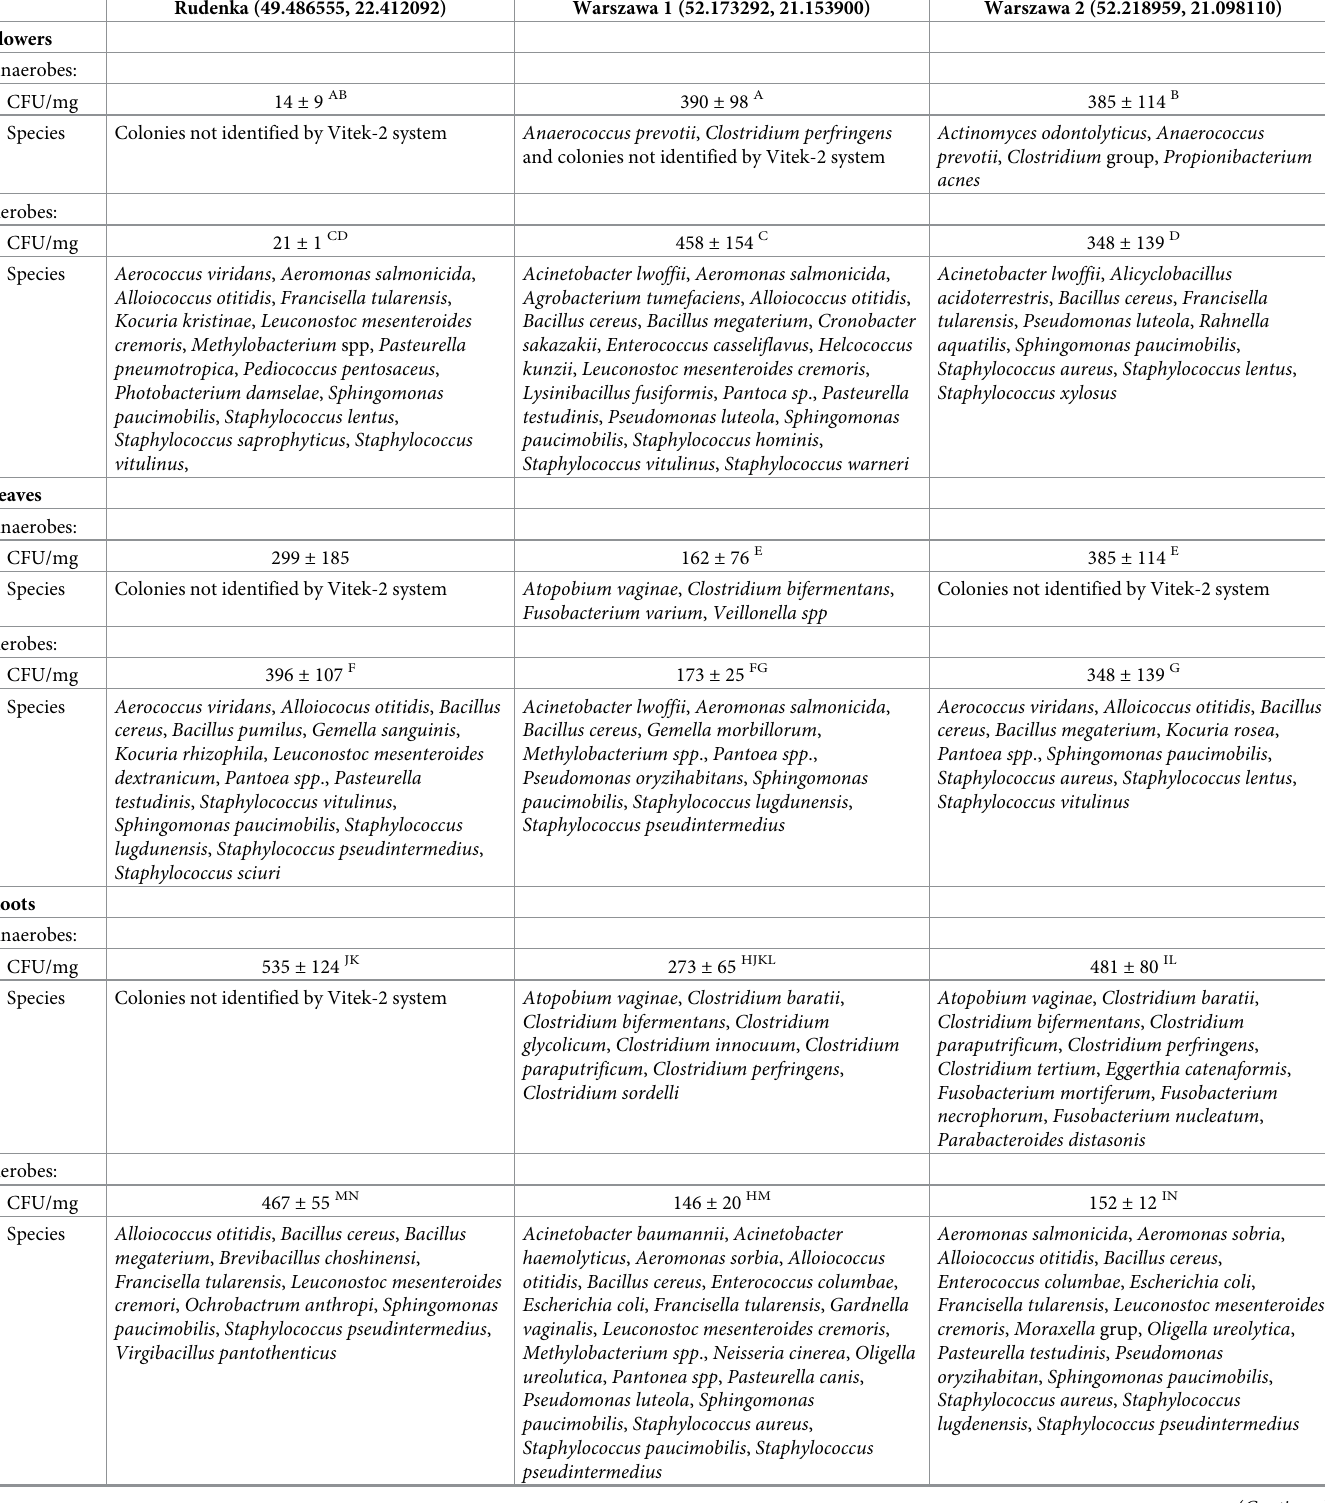
Table 4. Anaerobic and aerobic bacteria isolated from soil and various parts of Taraxacum officinale plants (CFU/mg of dried sample; mean ±